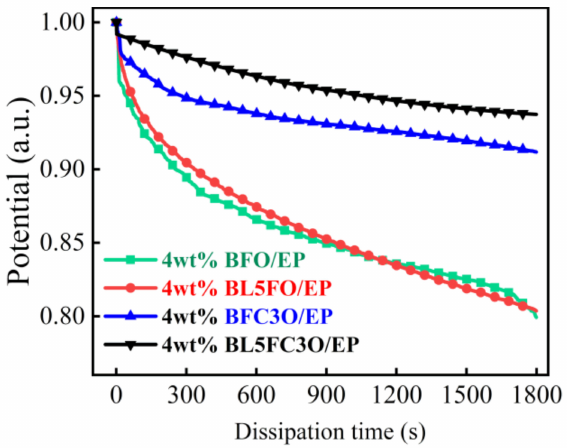
Figure 9. Charge dissipation curve of the composite with doped filler mass fraction of